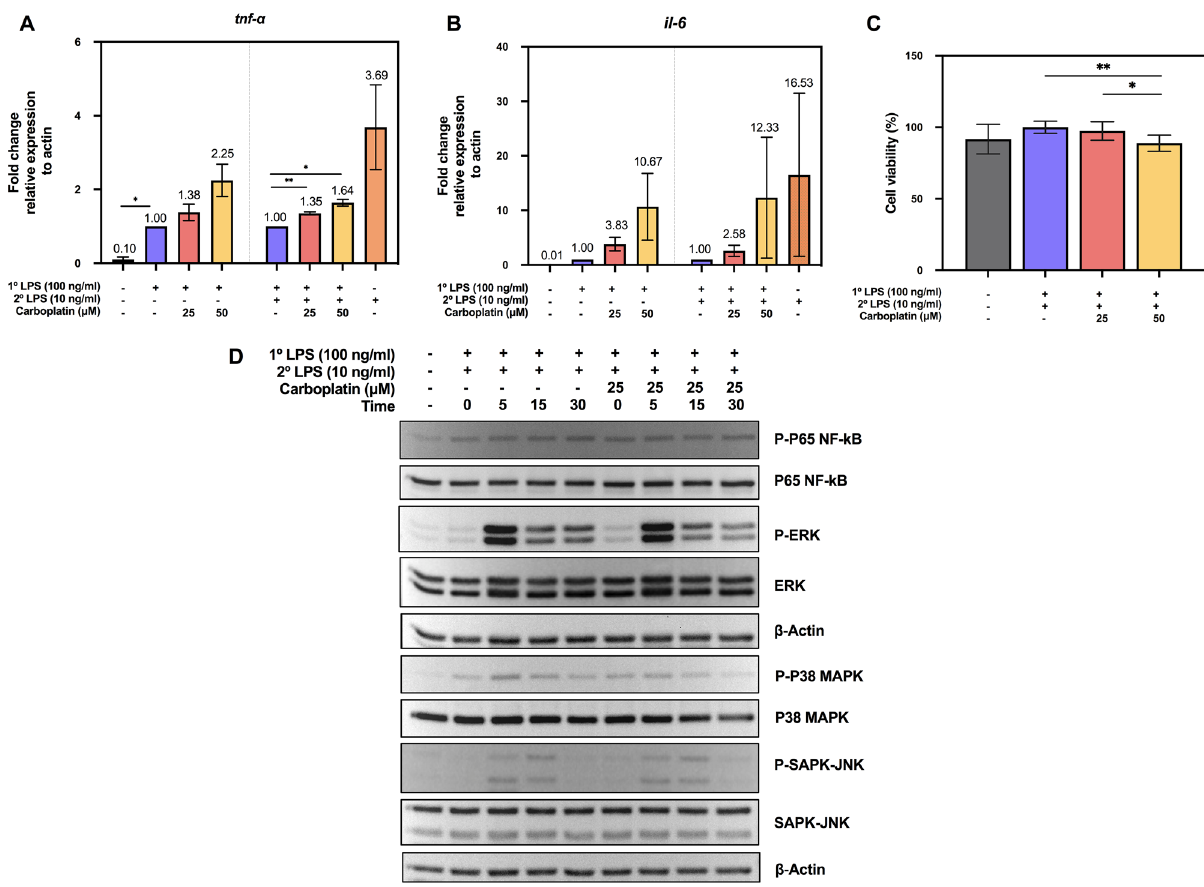
Figure 2. Effects of carboplatin on the transcription of tnf- α and il-6 and the TLR4 signaling pathway. ( A , B ) Total RNA from LPS-primed and LPS-tolerant BMDMs with or without carboplatin as described in Fig. 1 was subjected to RT-qPCR for tnf-α ( A ) and il-6 ( B ). Data are representative of 3 biological replicates. *, ** indicate p < 0.05 and 0.01, respectively, using one-way ANOVA. The numbers above the bars indicate fold differences compared to the cells without carboplatin. ( C ) Cell viability of LPS-tolerant macrophages in the presence or absence of carboplatin for 24 h was measured using an MTT assay. ( D ) Downstream TLR-4 signaling pathway activity in LPS-primed and LPS-tolerant macrophages with or without carboplatin was detected by western blotting. Actin and total targeted proteins were used as loading controls for each phosphorylated protein. The data shown are representative blots of replicates (n =